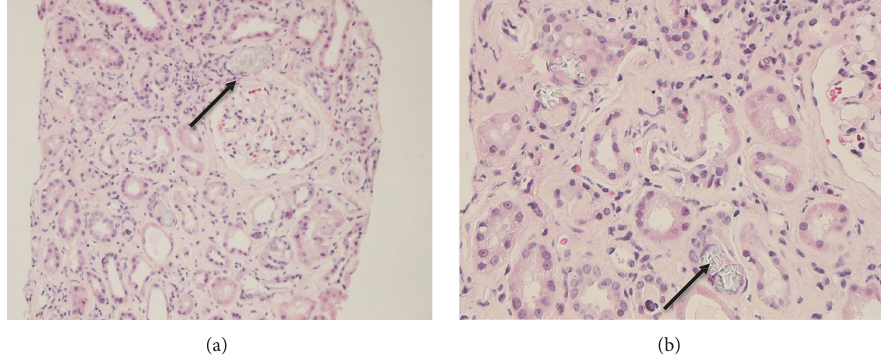
Figure 2: (a) Renal biopsy light microscopy (hematoxylin and eosin) showing renal tubules with severe acute injury, epithelial flattening and diffuse deposition of oxalate crystals within the cortex and medulla. (b) Renal tubules containing numerous oxalate